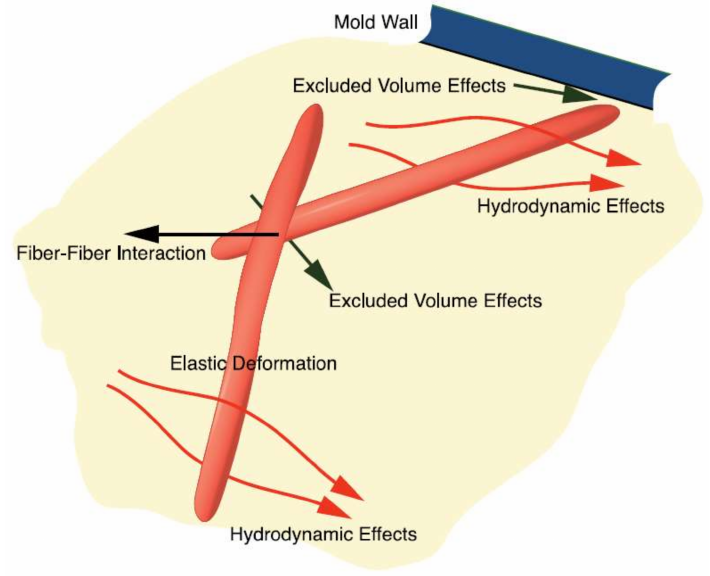
Figure 4. Fibre-fibre interaction and further effects which are included in the mechanistic model